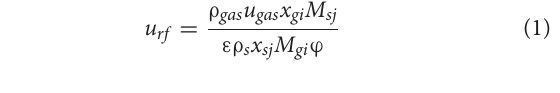
TABLE 2 | Operating conditions of every stage of the Ca-Cu looping process for the reference case. Conditions Value Solids